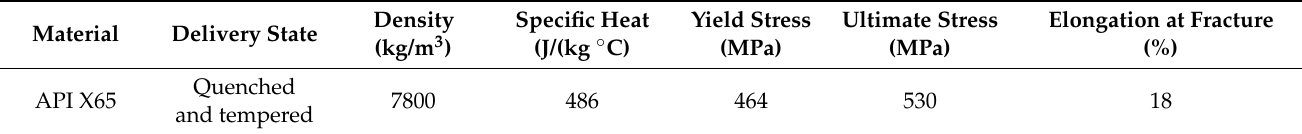
Table 1. API X65 mechanical properties taken from